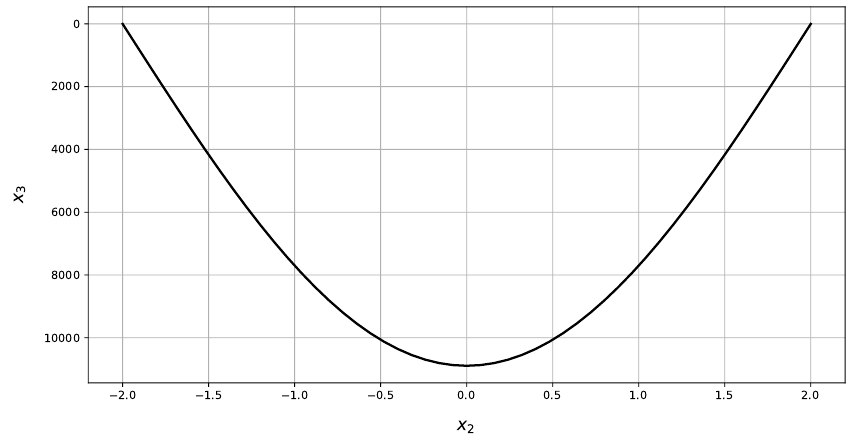
Figure 18. The bending moments M 22 in section x 1 = 0 of a simply supported rectangular plate.